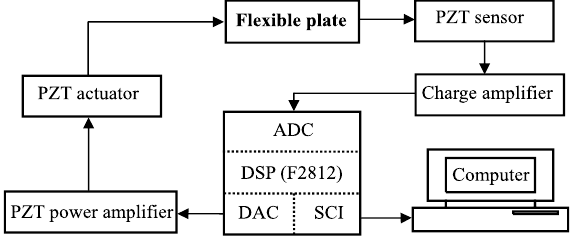
Fig. 4. Flow chart of experiment system.